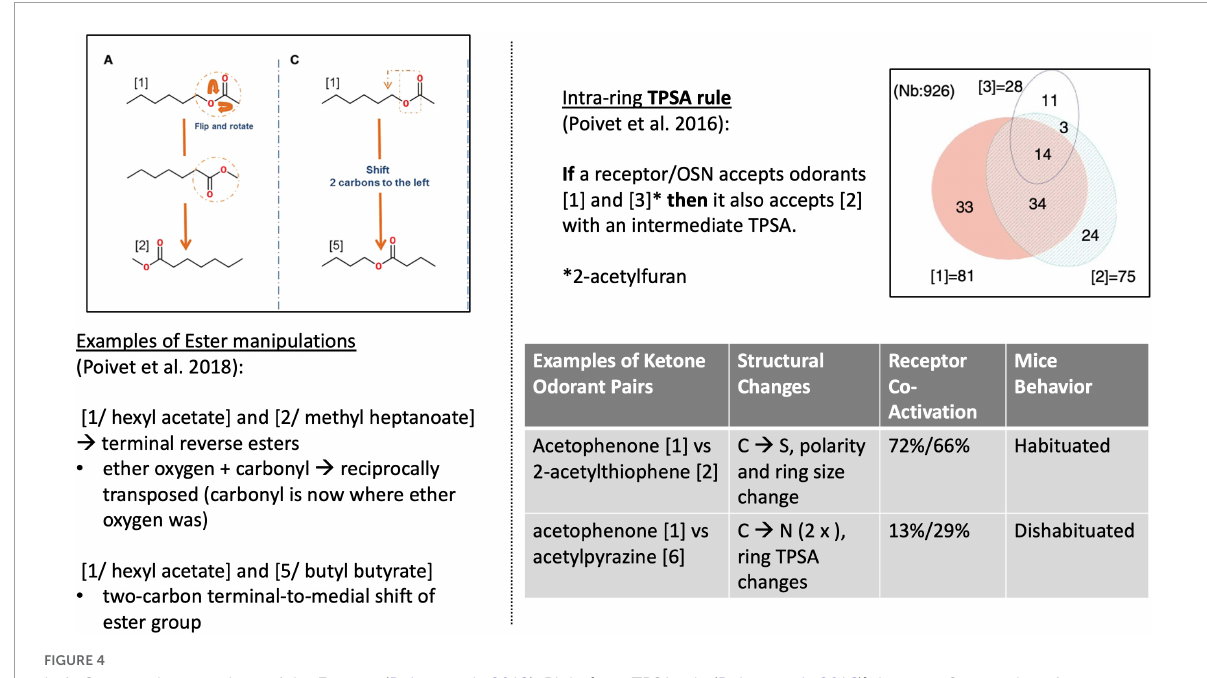
FIGURE4 Left: Structural comparison of the 3 esters (Poivet et al., 2018). Right [top: TPSA rule (Poivet et al., 2016)]; bottom: 2 examples of receptor co-activation in ketone pairs (Poivet et al., 2018).